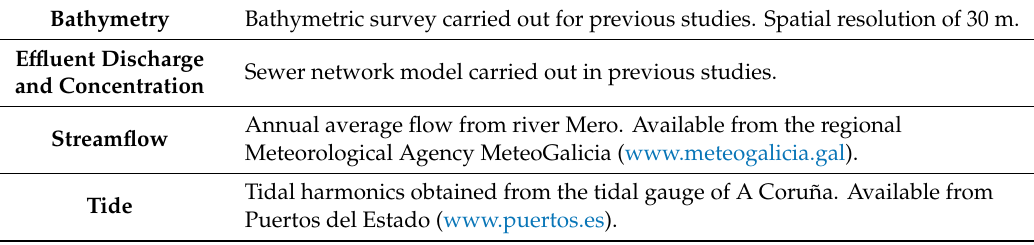
Table A2. Data sources for the Test Case 2.